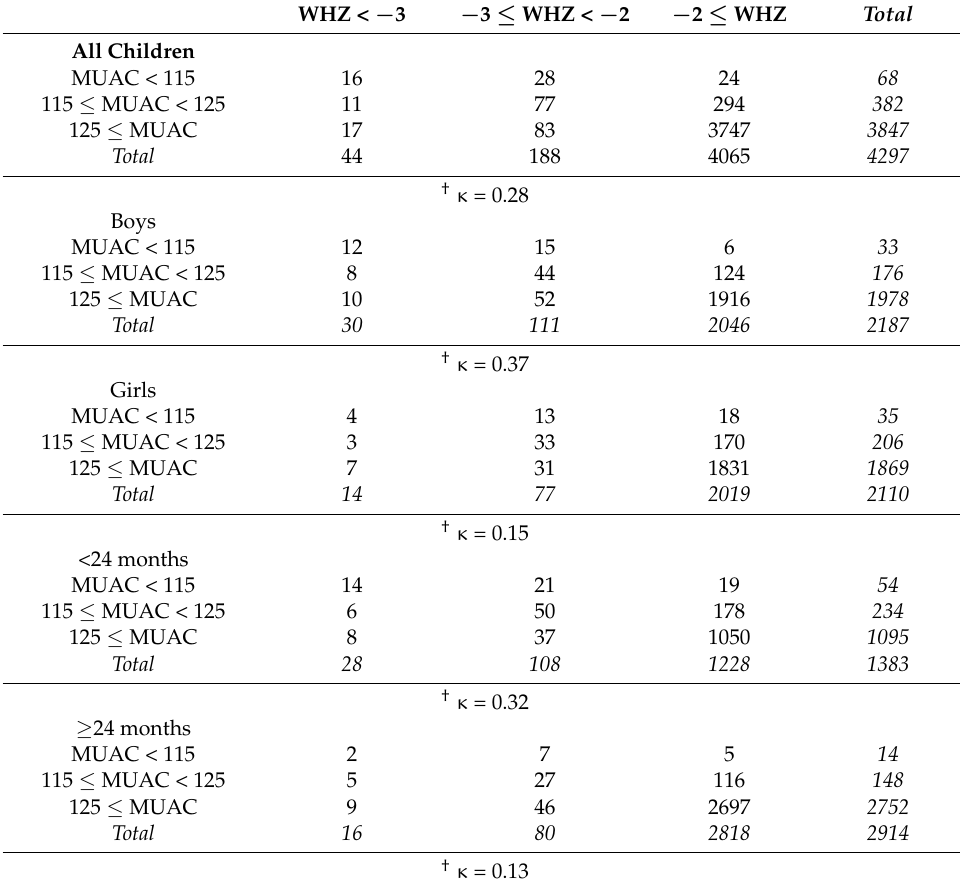
Table 3. Agreement between MUAC and WHZ to diagnose severe acute malnutrition by sex and